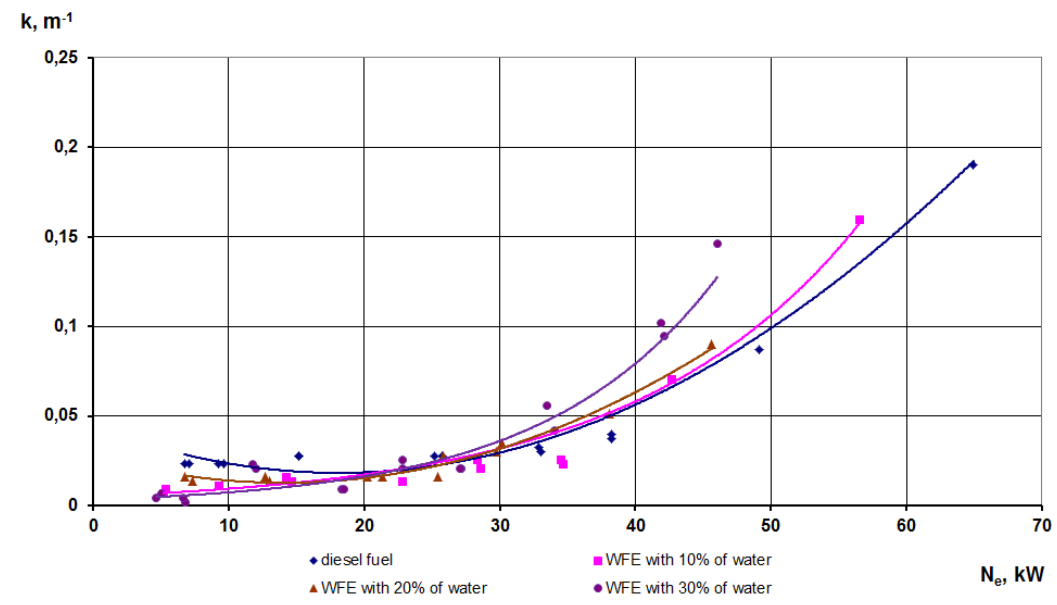
Figure 6. Smoke concentration in the exhaust gases at the load characteristic of the engine when working on diesel fuel and water–fuel emulsions at an engine speed of 1700